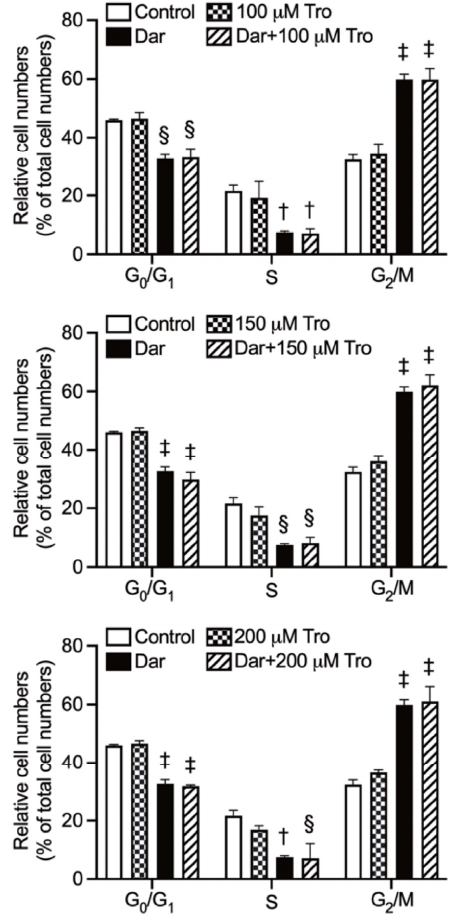
Figure 9. Effect of Trolox on cell cycle profiling in NB4 cells treated with darinaparsin. After treatment for 6 h with 1 µ M darinaparsin in the presence or absence of 100, 150 and 200 µ M Trolox, cell cycle analysis was performed as described in the legend of Figure 6. Quantification of the percentages of cells at the G 0 /G 1 , S and G 2 /M phase fractions are shown. Results are shown as the means ± SD from more than three independent experiments. †, p < 0.01; §, p < 0.001; ‡, p < 0.0001 vs. control. Dar, darinaparsin; Tro,